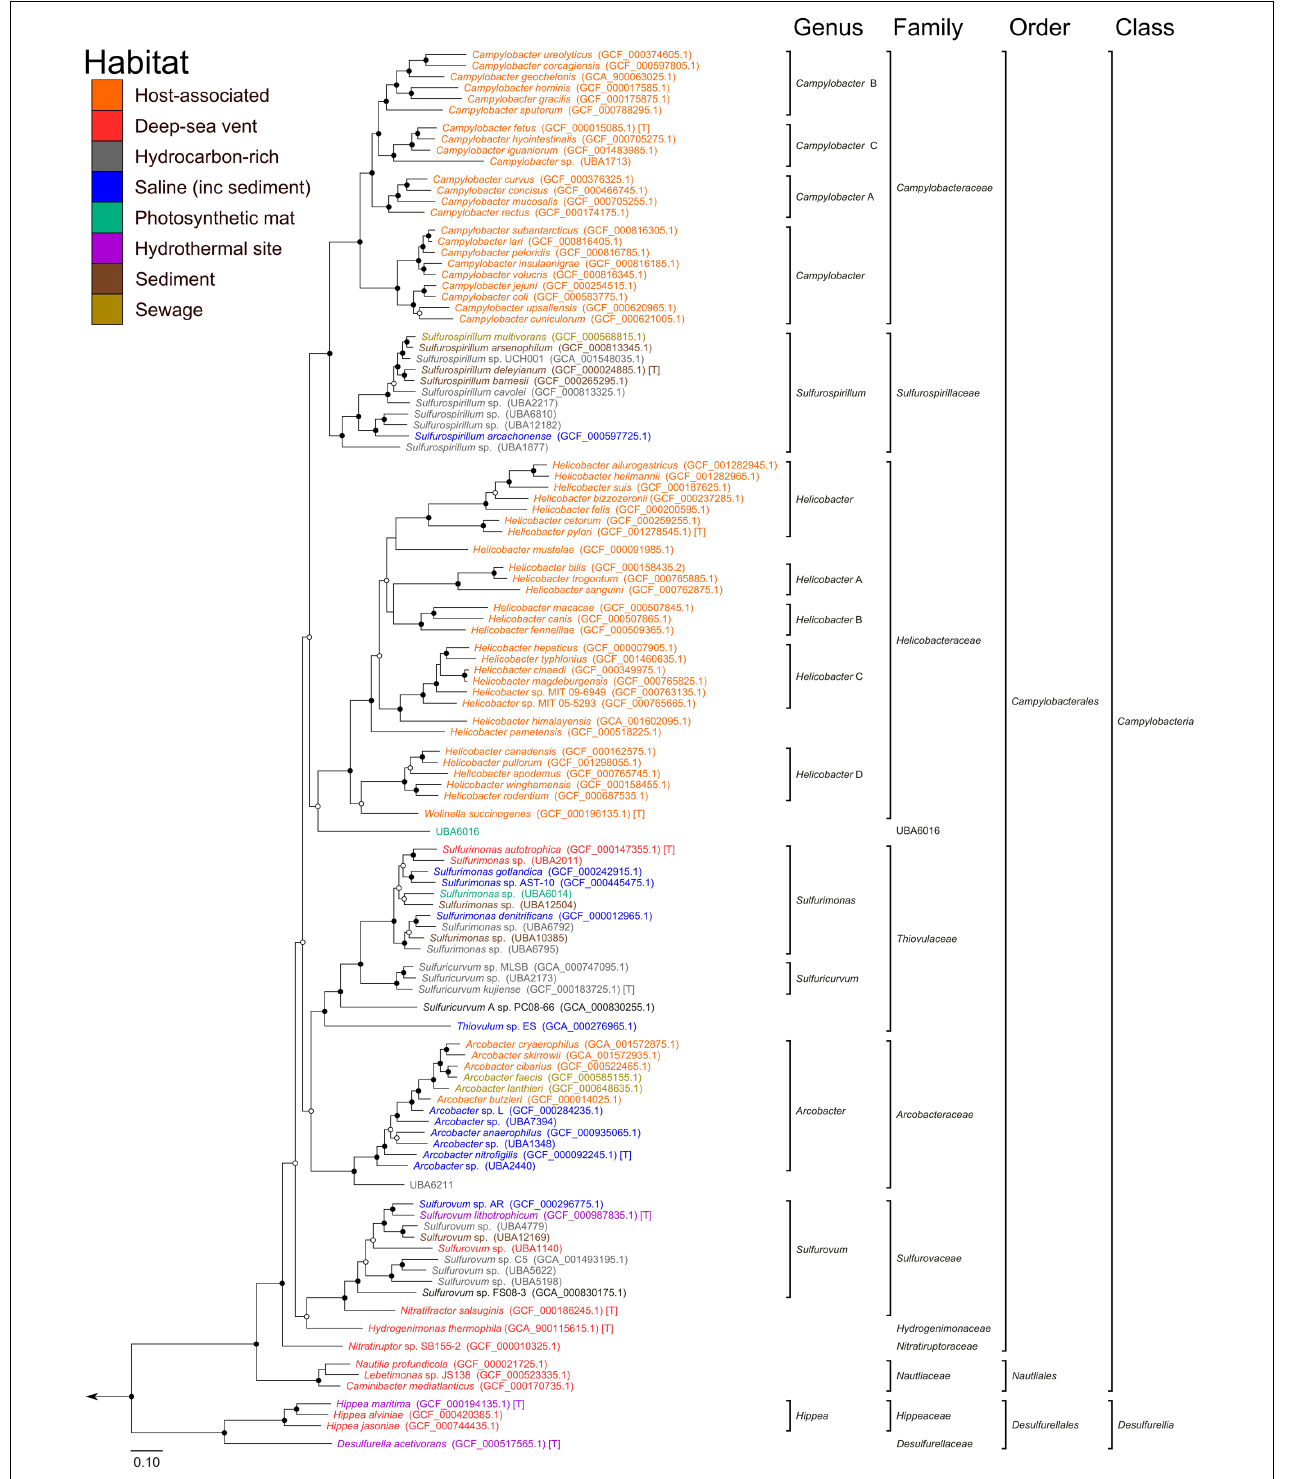
FIGURE 2 | Phylogenetic analysis of the Epsilonbacteraeota. Maximum likelihood tree of the Epsilonbacteraeota based on 120 concatenated protein marker sequences using RAxML. Support of internal nodes was calculated using 100 bootstrap iterations, and junctions represent nodes with 100% bootstrap support (solid), and > 75% support (hollow). All taxonomic groupings are identical to those in Figure 1 (calculated with FastTree), although the branching positions of Helicobacteraceae and Sulfurovaceae differs between the two topologies. [T]: denotes type species.